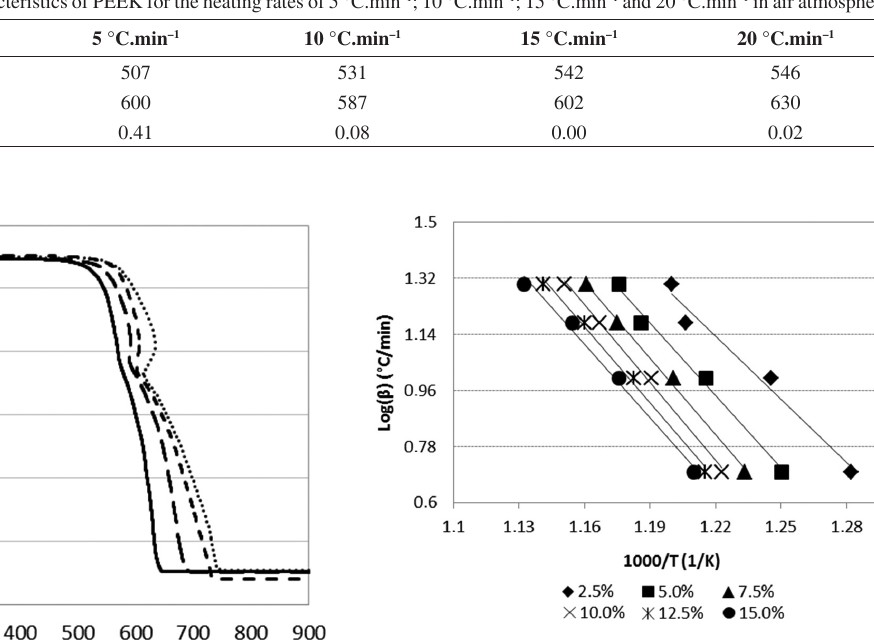
Figure 9. Plot of log b versus 1000/T and mathematical adjustment by least squares method for the conversion rates of 2.5%, 5%, 7.5%, 10%, 12.5% and 15%.